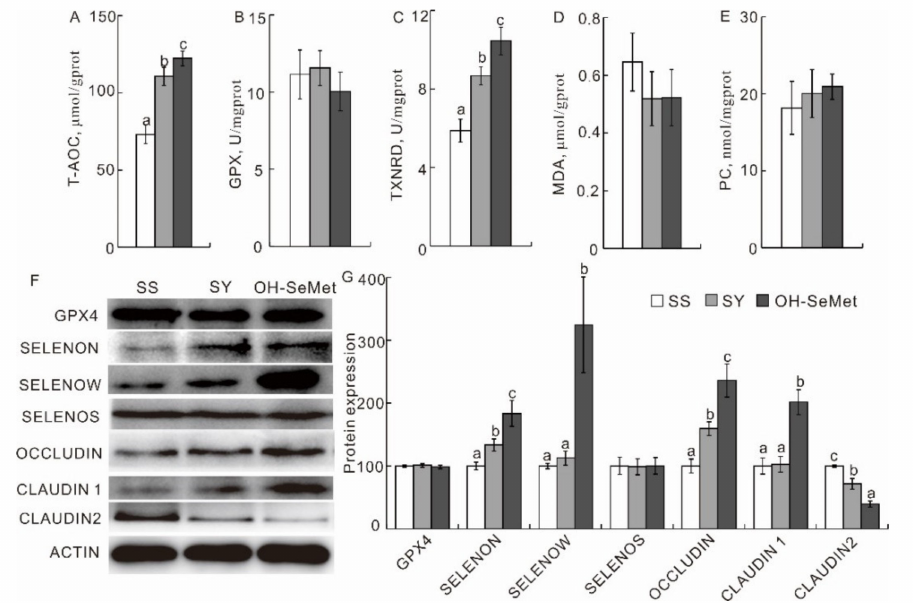
Figure 3. Effect of the three forms of Se on the T-AOC ( A ), GPX ( B ), TXNRD ( C ), MDA concentration ( D ), PC concentration ( E ), and protein production of GPX4, SELENON, SELENOW, SELENOS, OCCLUDIN, CLAUDIN1 and CLAUDIN2 ( F , G ) activities in the jejunum of broilers. The values are the means ± SE, n = 12 for the redox status, n = 3 for the western blot. Labeled means within the same plot without a common letter differ, p < 0.05. ACTIN, β -actin; GPX, GPX4, glutathione peroxidase, glutathione peroxidase 4; MDA, malondialdehyde; PC, protein carbonyl; SELENON, S, W, selenoprotein N, S, W; T-AOC, total antioxidant capacity; TXNRD, thioredoxin reductase; SS, basal diet supplemented with 0.3 mg Se/kg as sodium selenite; SY, basal diet supplemented with 0.3 mg Se/kg as seleno-yeast; OH-SeMet, basal diet supplemented with 0.3 mg Se/kg as